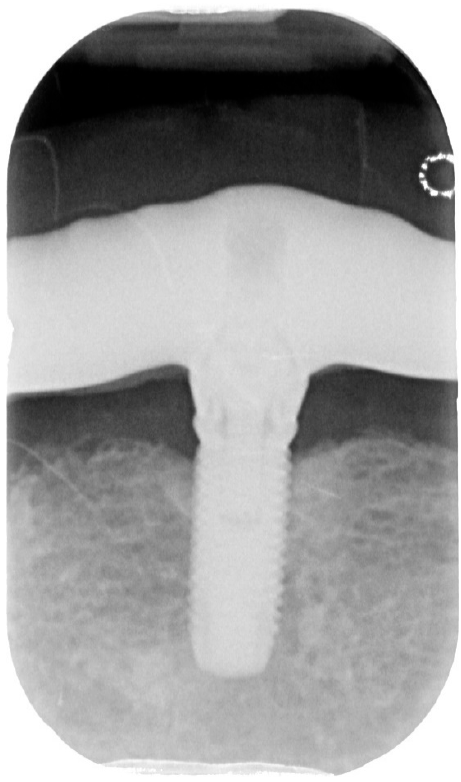
Figure 5. X-ray of dental implant area after treatment.